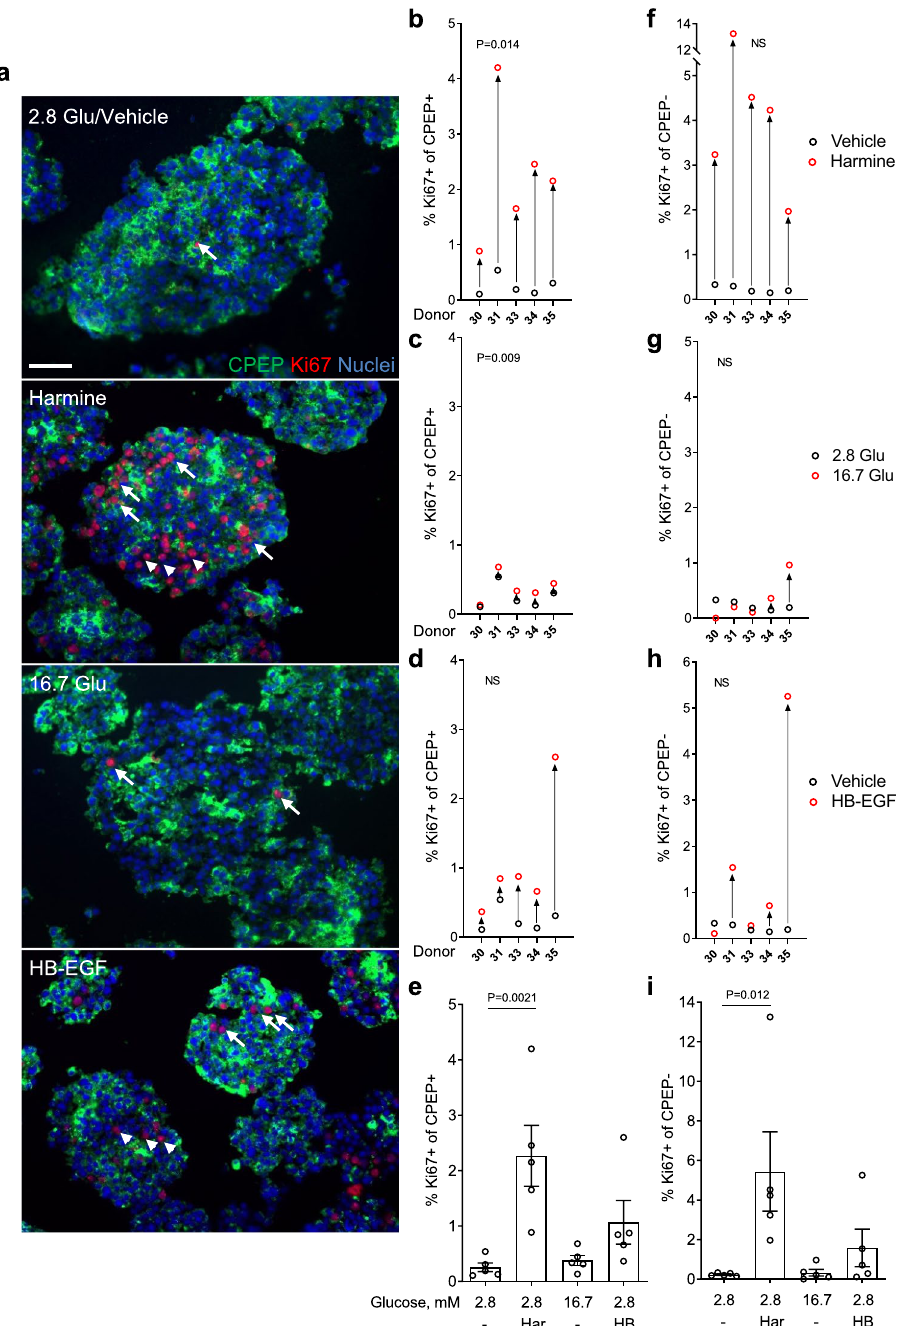
Figure 4. Analysis of β-cell proliferation in intact human islets by immunohistochemistry for Ki67. ( a – i ) Intact human islets were exposed to 2.8 mM glucose (Vehicle or 2.8 Glu; a – i ), harmine (10 μM) (Har; a , b , e , f , i ), 16.7 mM glucose (16.7 Glu; a , c , e , g , i ) and HB-EGF (100 ng/ml) (HB; a , d , e , h , i ) for 72 h. Proliferation was assessed by staining for Ki67 and C-peptide (CPEP) to mark β cells. Representative images of CPEP (green), Ki67 (red) and nuclei (blue) staining are shown ( a ). Arrows and arrowheads highlight Ki67 + /CPEP + and Ki67 + /CPEP − cells, respectively. Scale bar, 50 μm. Images were acquired using an Axio Imager with ZEN 2012 software (https:// www. zeiss. com/ micro scopy/ int/ produ cts/ micro scope- softw are/ zen. html). A minimum of 1500 CPEP + and CPEP − cells were counted for each sample. Proliferation is presented as the percentage of Ki67 + / CPEP + over the total CPEP + cells ( b – e ) or Ki67 + /CPEP − cells over the total CPEP − cells ( f – i ). Graphs showing cell proliferation of individual ( b – d , f – h ) and combined ( e , i ) donors were generated using GraphPad Prism 9 software (https:// www. graph pad. com/ scien tific- softw are/ prism/). Donor identifiers (Supplementary Table S1 online) are indicated. Significance was tested using paired t tests ( b – d , f – h ) or one-way ANOVA ( e , i ). P < 0.05 was considered significant. NS not